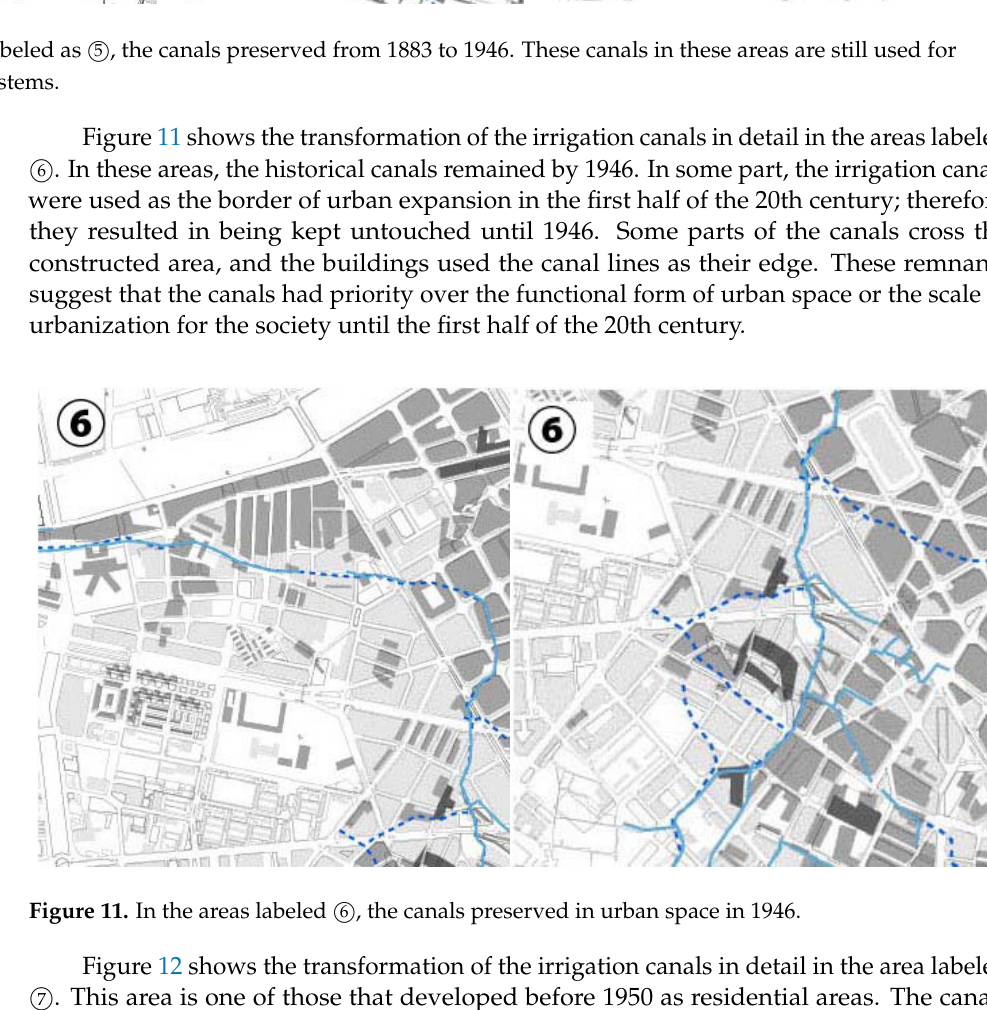
Figure 10. In the areas labeled as ⑤, the canals preserved from 1883 to 1946. These canals in these areas are still used for agricultural irrigation systems.